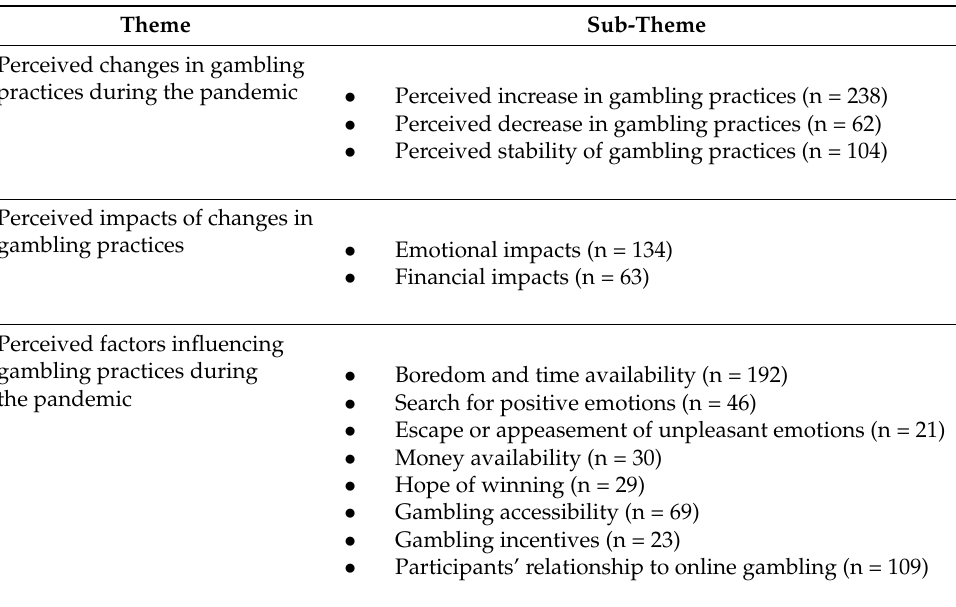
Table 2. Thematic framework of the experience of gamblers during the COVID-19